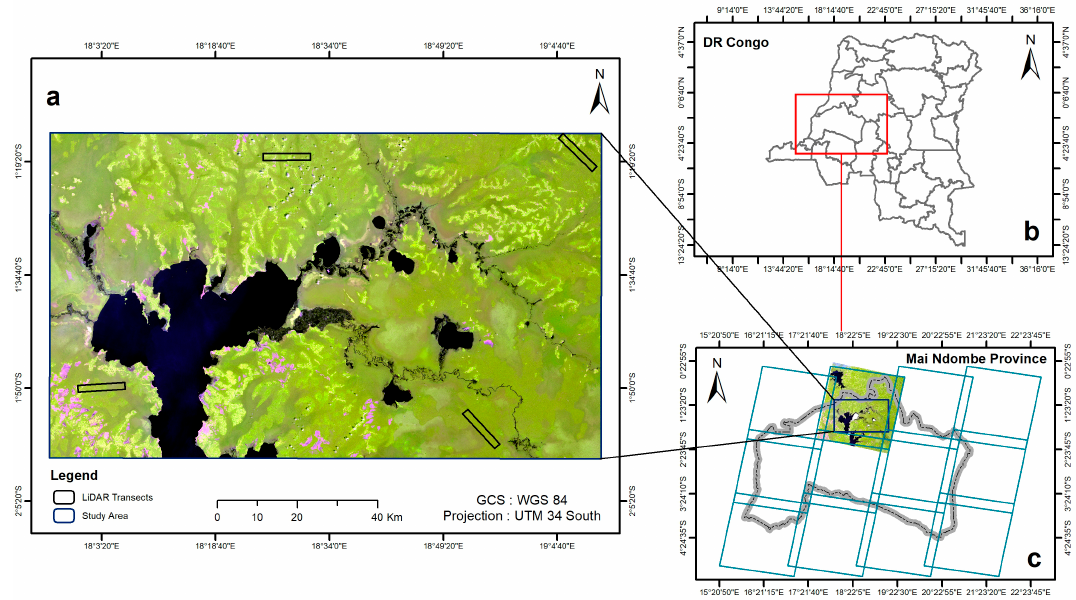
Figure 1. Study area showing, ( a ) the extent (black boxes) of the four airborne LiDAR transects superimposed on wet season December 8th 2014 Landat-8 false color (1610 nm, 865 nm, 655 nm) surface reflectance, ( b ) the study area location in Mai Ndombe province within the Democratic Republic of Congo, ( c ) the Landsat (WRS) 185 × 170 km image path / row coordinate map, the study area falls within Landsat Path 180 and Row